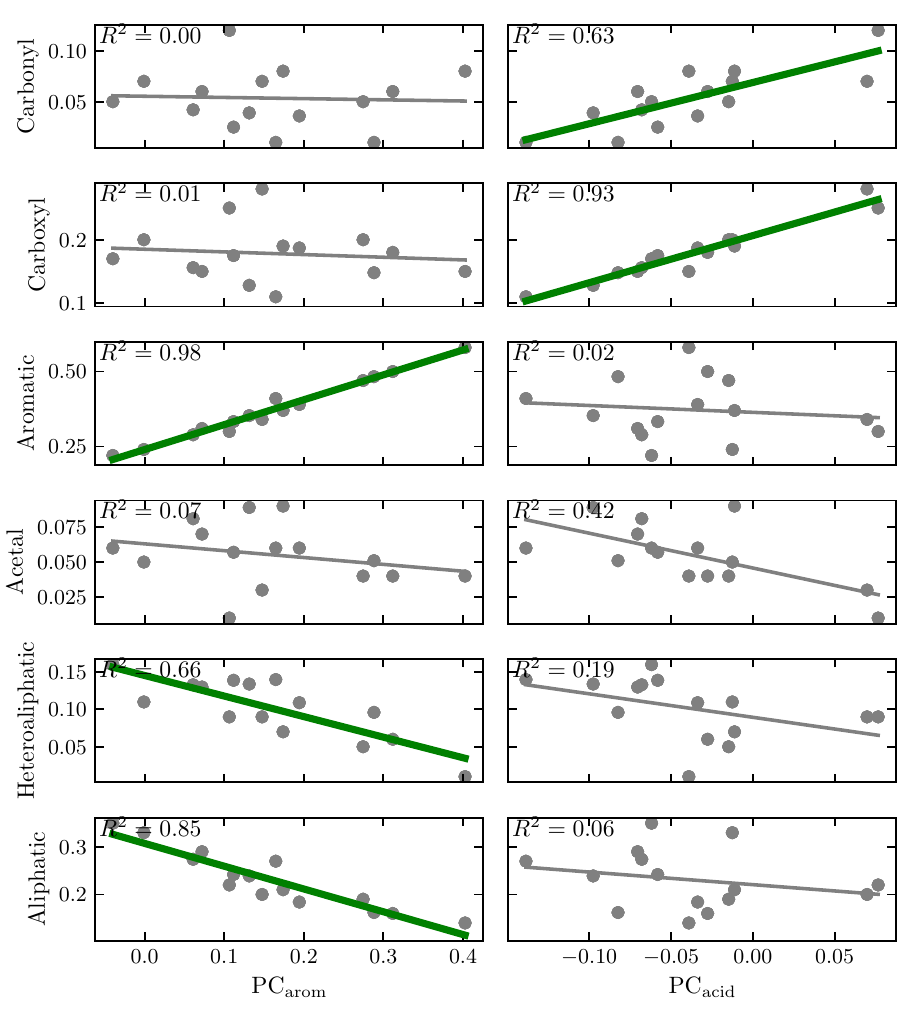
Figure A3. Correlation of the principal components PC arom and PC acid with the organic composition of the humic substances. Each plot has a fitted line using linear regression, which is presented with a green tick curve if the R 2 is greater than